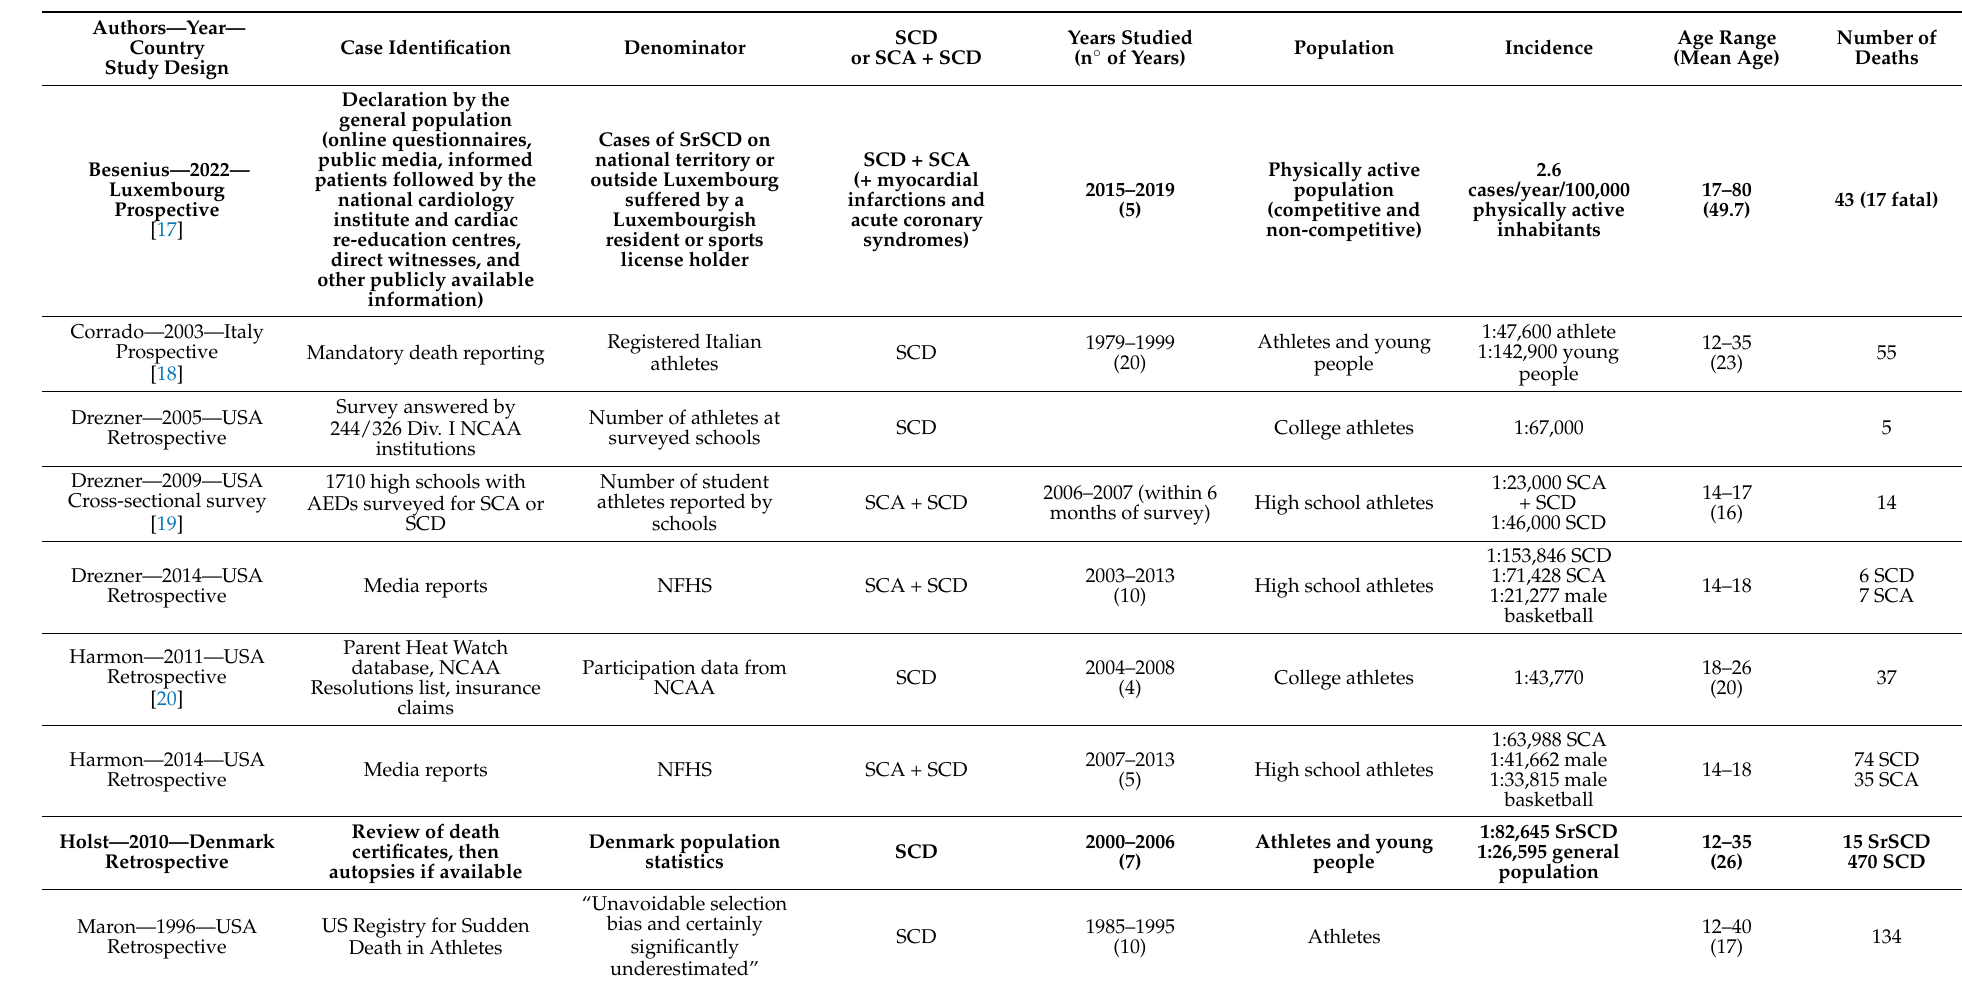
Table 1. Main studies reporting on Incidence of SCD in